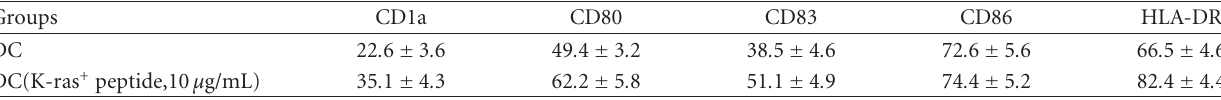
Table 1: Surface marker of DCs induced by di ff erent antigens (%, X ± SD, n = 6). Groups